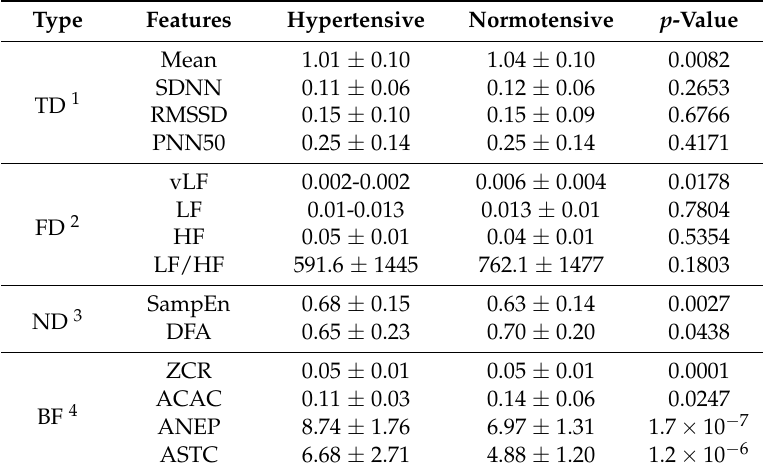
Table 4. A summary of the extracted features (mean ± standard deviation).